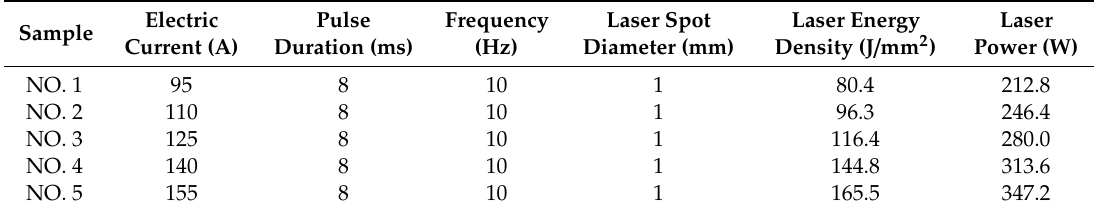
Table 2. Details of the biomimetic specimens and laser processing parameters.